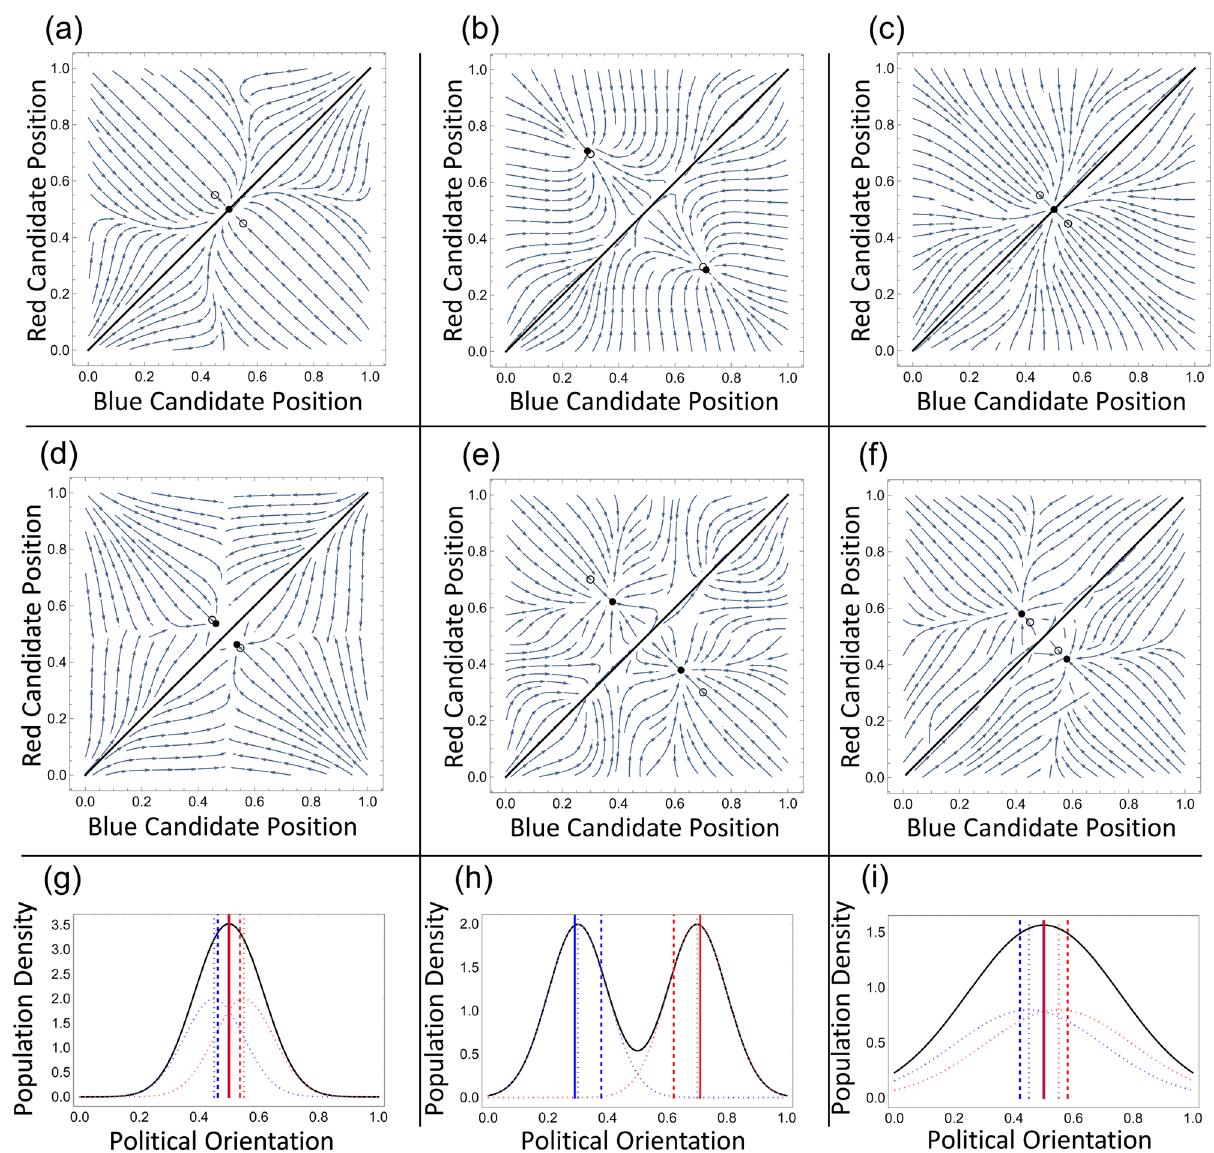
Fig. 5 Optimal position of two competing major candidates with different third-party behavior. a – c show candidate behavior with two extreme third- parties, and ( d – f ) correspond to a single third-party located at 0.5. The black dots represent the candidates ’ equilibria and the circles show the subpopulation peaks. g – i show the corresponding populations in black, the two subpopulations with dashed curves, the subpopulation centers represented by lightly colored and dashed vertical lines, the candidate equilibrium positions in the extreme condition represented by darkly colored and solid vertical lines, and candidate equilibrium positions in the centrist condition represented by darkly colored and dashed vertical lines. When the population is bimodal ( h ), centrist parties “ pull-in" main candidates from the ideological peaks ( b ) instead of matching the ideological peaks of the voters ( e ). However, when the population is more unimodal ( g , i ), centrist third-party candidates either prevent main-parties from completely converging to the center ( d ) or push them away from the center ( f ), compared to extreme third-party candidates ( a , c ) who cause the main-parties to converge to the center. All plots use the set of parameters P = 5, Q = 0, and R =